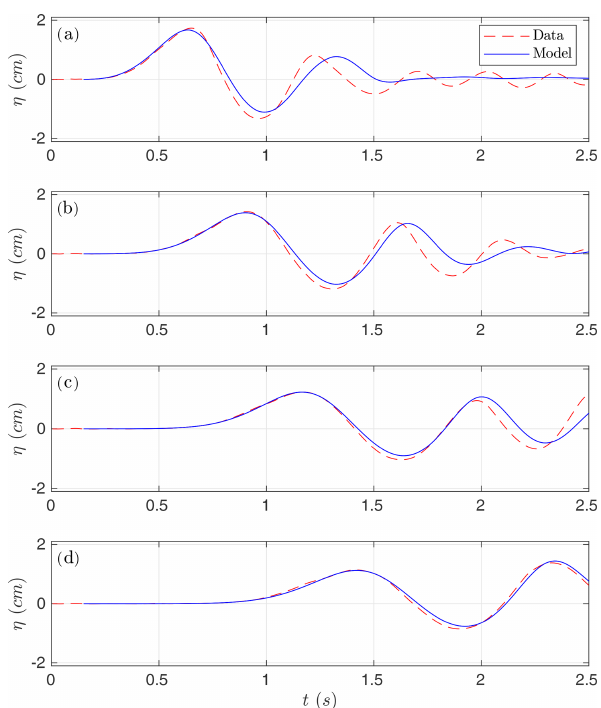
Figure 6. Numerical time series for the simulated water surface (in blue) compared with lab-measured data (red). Case 1 at